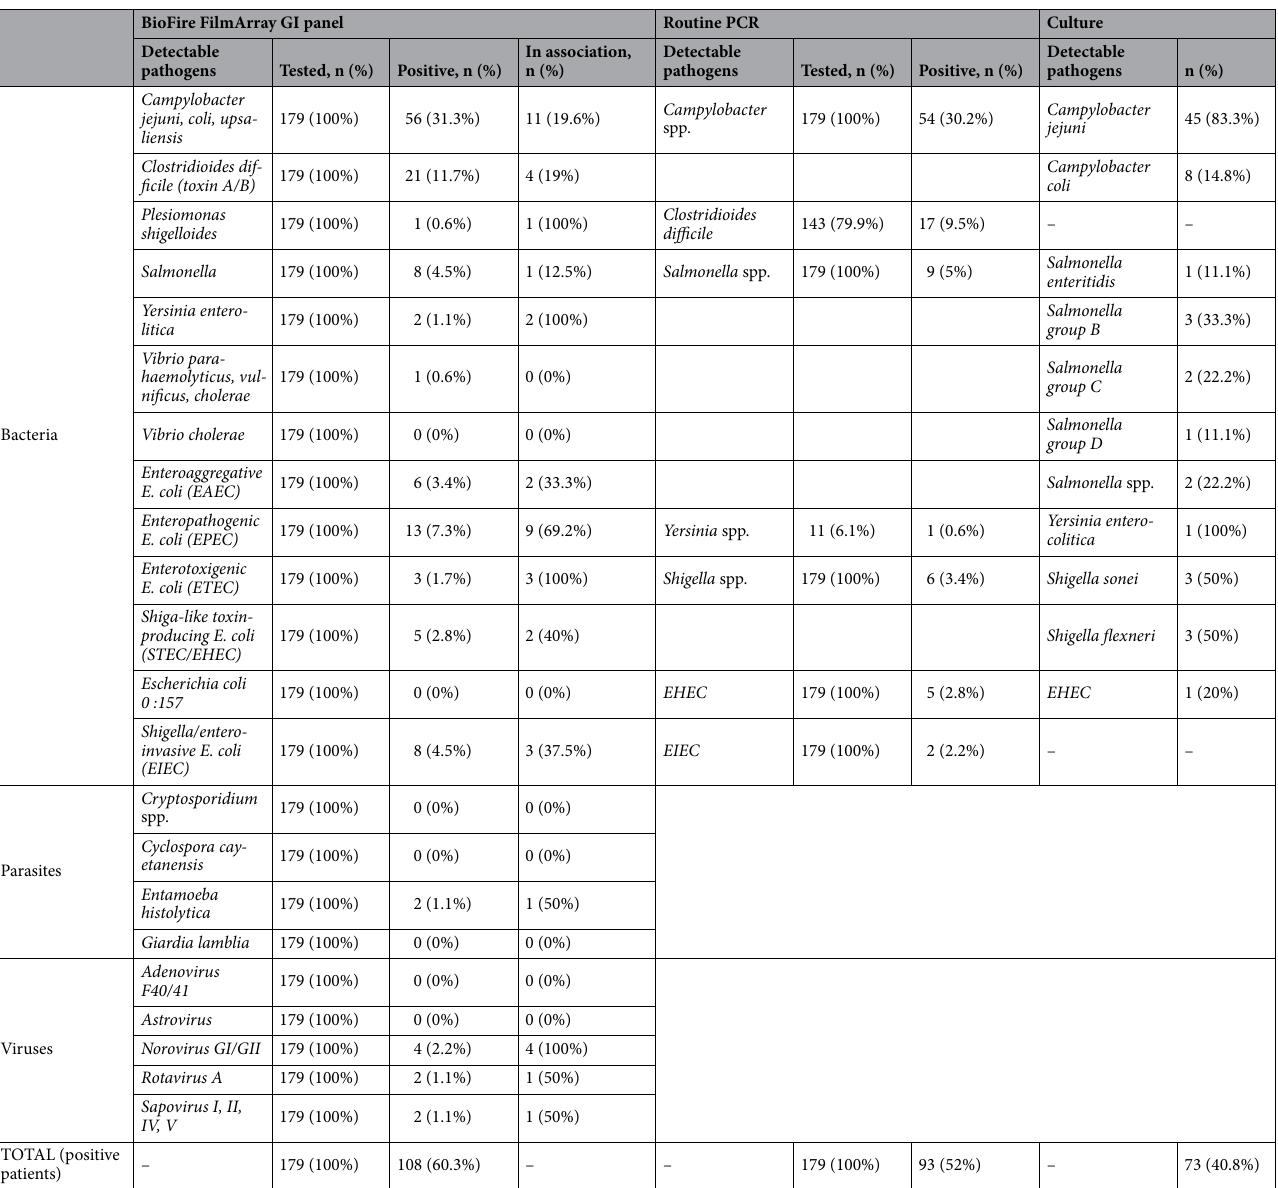
Table 2. Microbiological examination of the feces. Feces of patients with computed tomography-proven acute colitis were screened for pathogens using the multiarray PCR FilmArray GI panel and the PCR array BD-Max. If BD-Max was positive, pathogens were further characterized using fecal